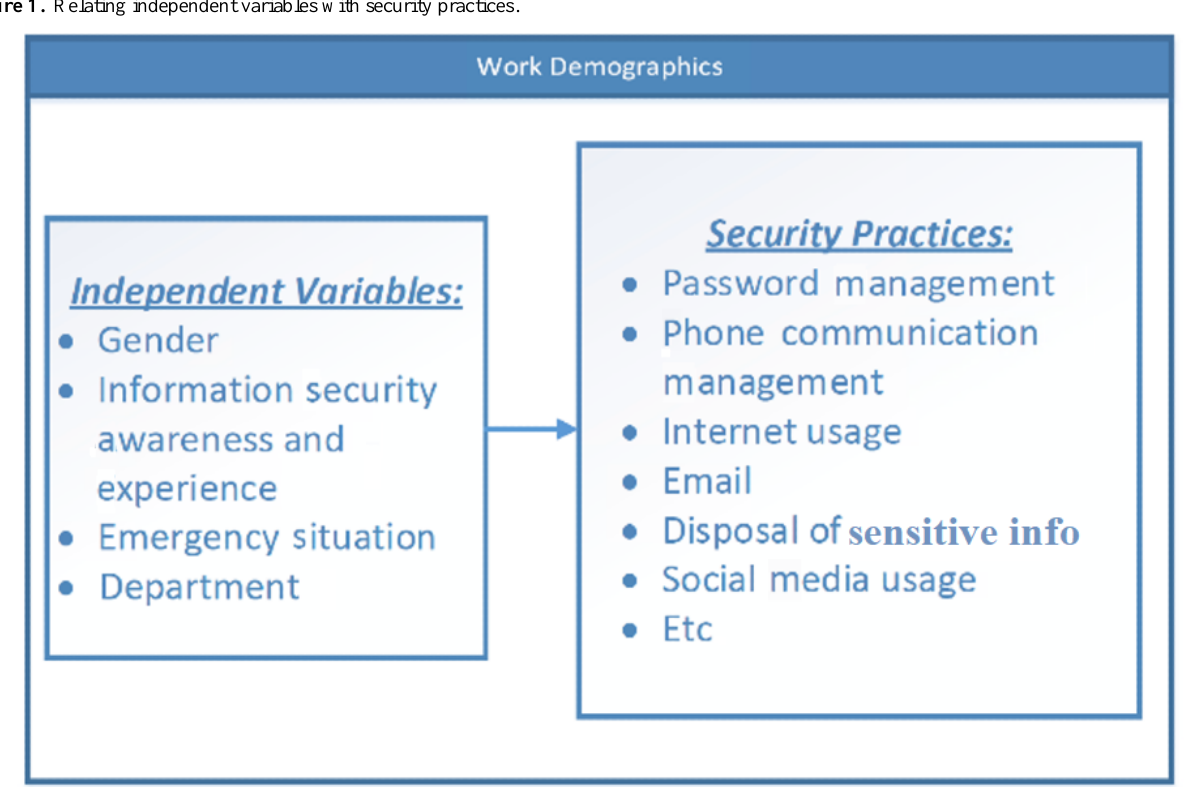
Figure 1. Relating independent variables with security